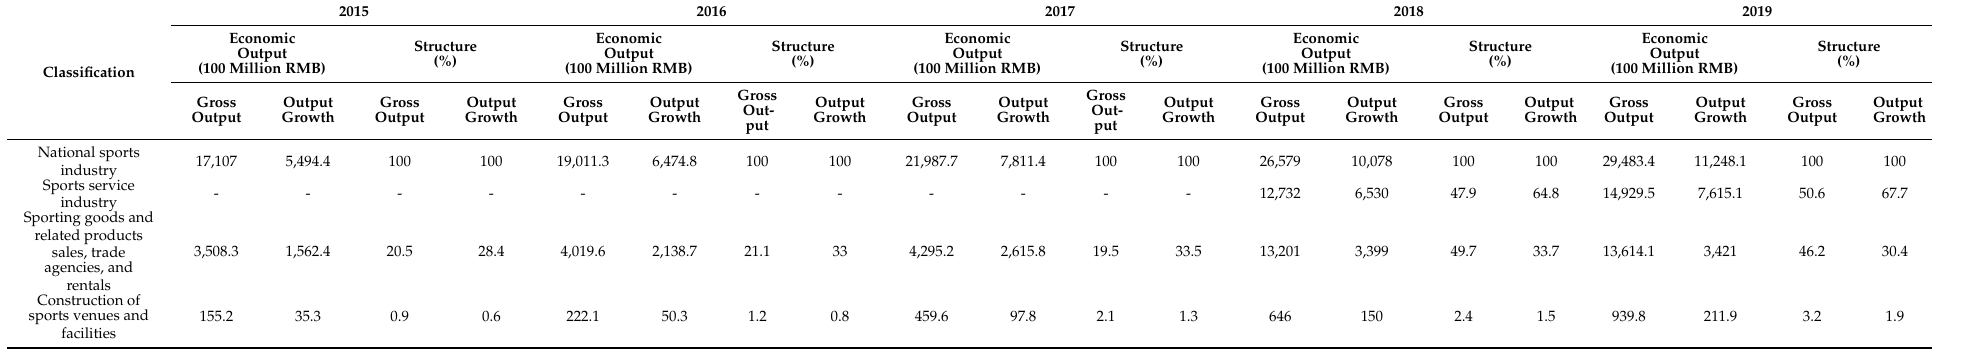
Table 2. Sports economics of China; data from